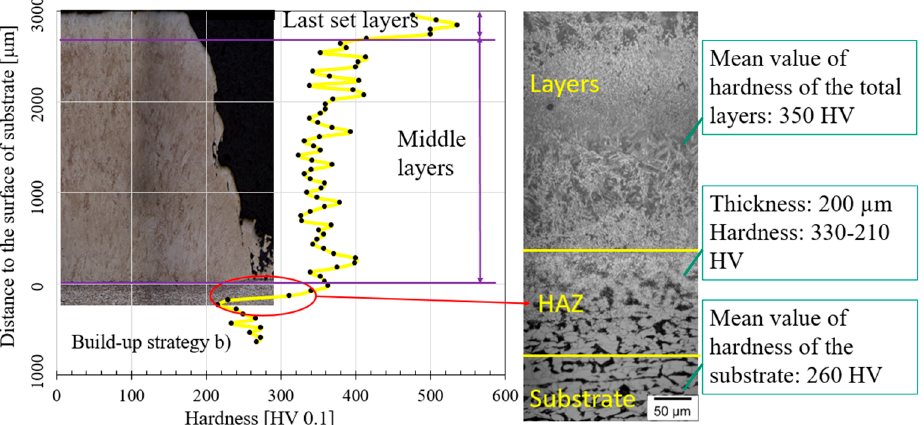
Figure 15. Hardness distribution and its corresponding light microscope photography for strategy a: One single layer as a set.